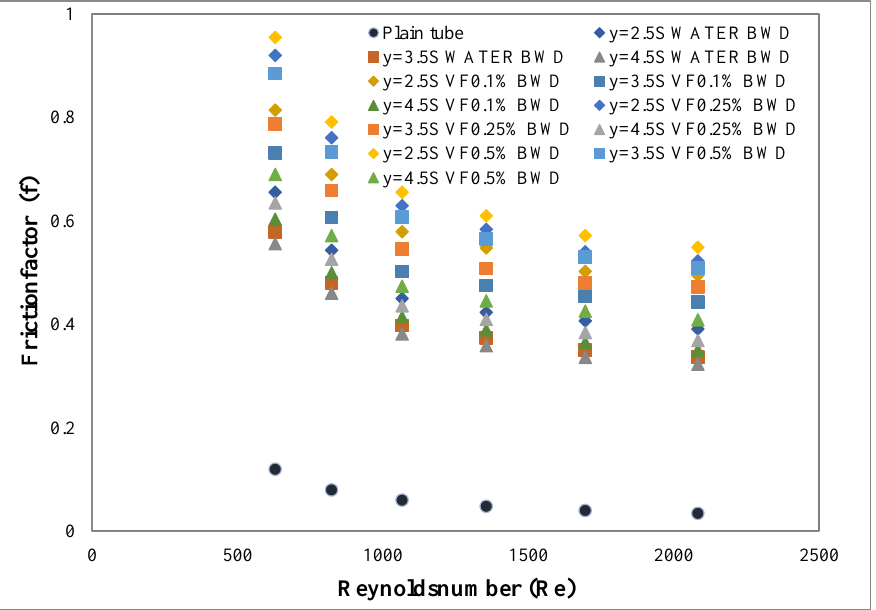
Figure 13. Friction factor versus Reynolds number for a staggered conical strip insert with the backward arrangement using deionized water and ZrO 2 / deionized water nanofluids under laminar flow conditions.